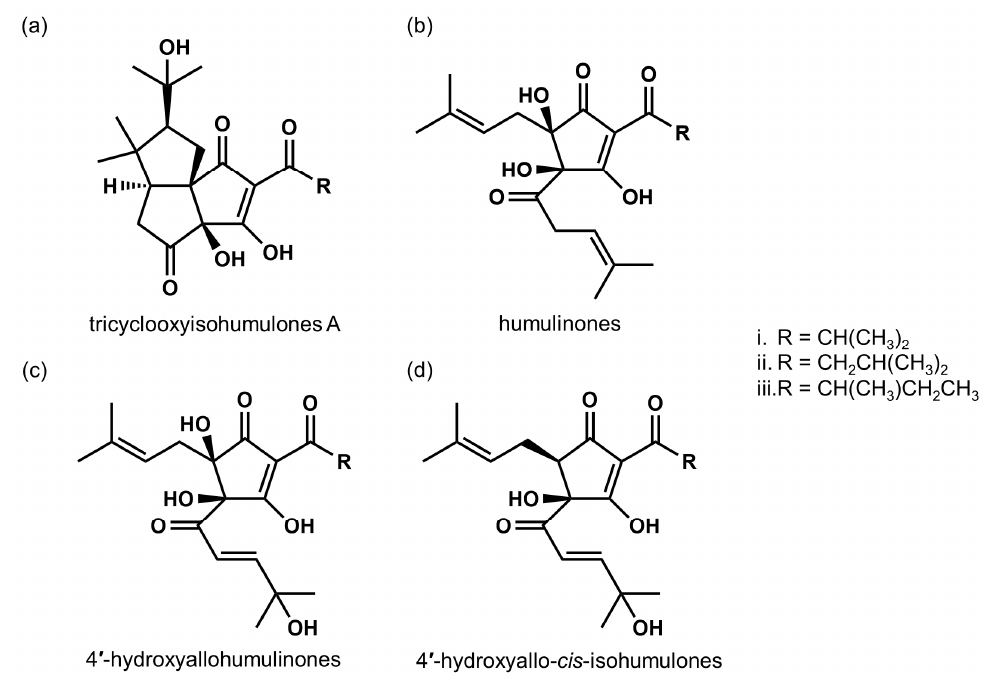
Figure 2. Chemical structures of representative MHBA components. ( a ) tricyclooxyisohumulones A; tricyclooxyisocohumulone A (i), tricyclooxyisohumulone A (ii), and tricyclooxyisoadhumulone A (iii). ( b ) humulinones; cohumulinone (i), humulinone (ii), and adhumulinone (iii). ( c ) 4 ′ -hydroxyallohumulinones;